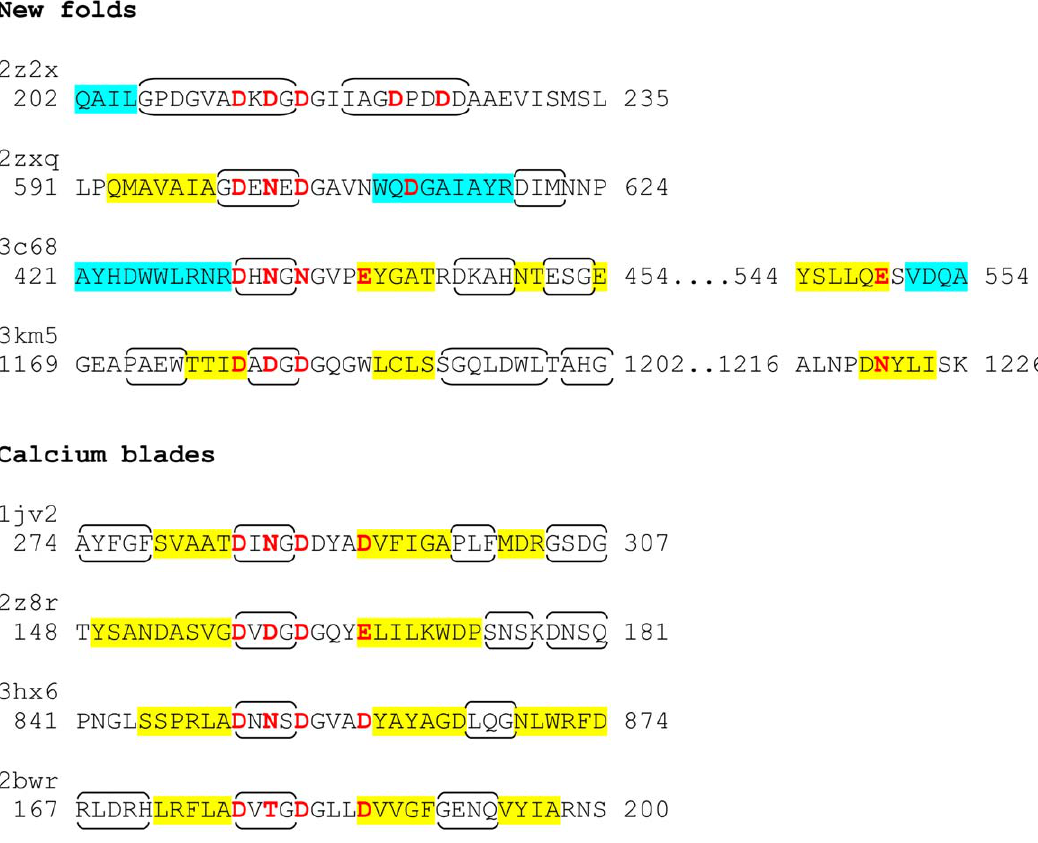
Figure 3. Secondary structure context of the Dx[DN]xDG motifs, highlighting additional metal-binding residues (Table 1). Residues binding to metal using side chains are in red (direct interaction with calcium) or purple (through-water interaction). Secondary structure as defined by STRIDE [78] is indicated as follows: a -helices, blue shading; b -strands, yellow shading; turns, brackets. A version including previously reported families is included as Figure S1.